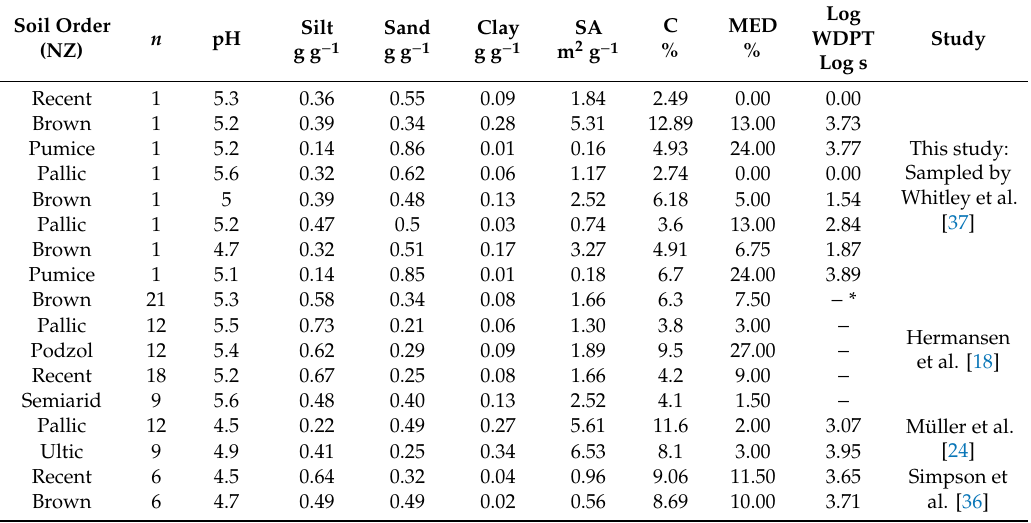
Table 3. Soil characteristics from our study and other studies including pH, sand, silt, clay, C contents, surface area (SA), molarity of ethanol drop (MED) and Log WDPT.